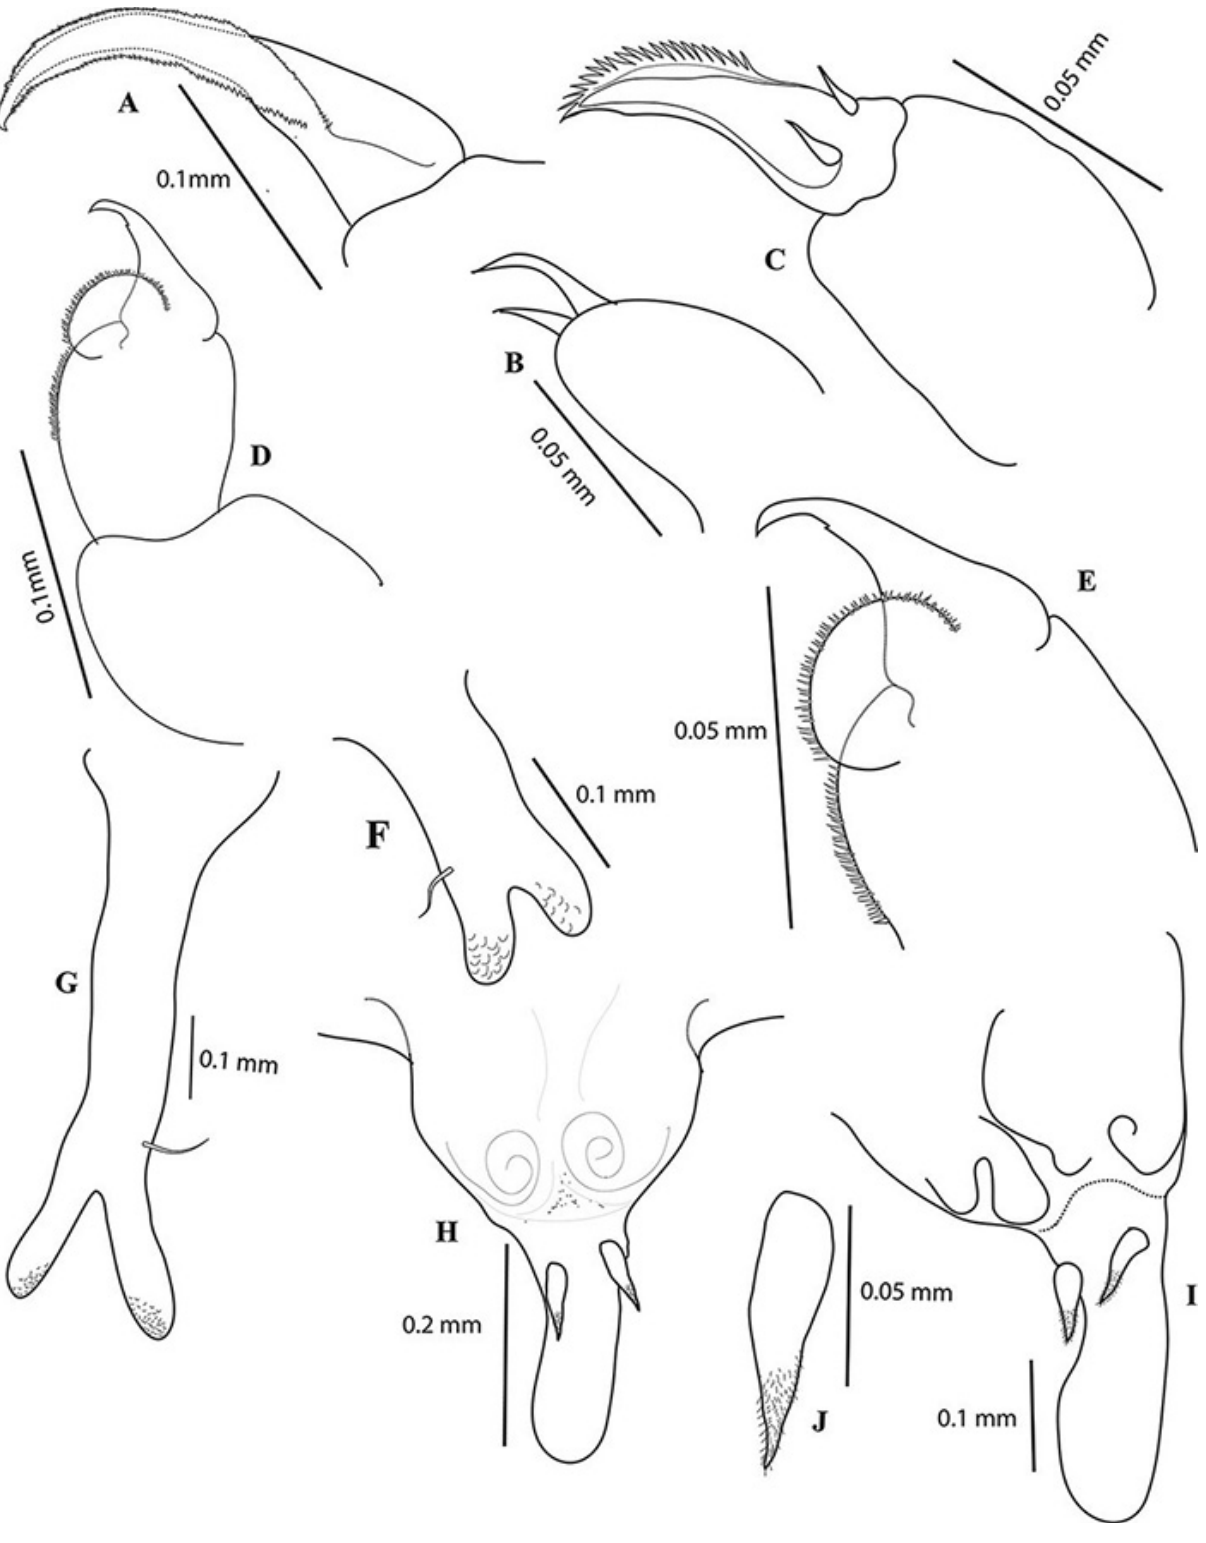
Figure 4. Acanthochondria krishnai sp. n., paratype, female from Uranoscopus guttatus Cuvier. A . Mandible. B . Maxillule. C . Maxilla. D . Maxilliped. E . Maxilliped apex. F . Leg 1. G . Leg 2. H, I . Genito-abdomen with rami, ventral and ventro-lateral views. J .